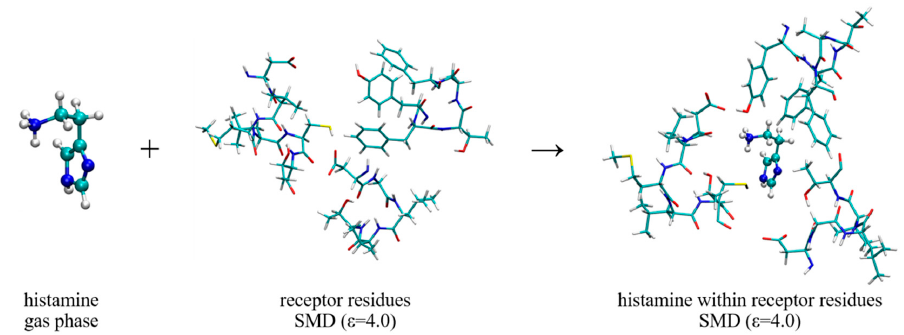
Figure 8. Computational scheme to estimate the interaction energy of the histamine monocation with the H 2 receptor, ∆ E INTER . The selection of dielectric constants is specified in round brackets.